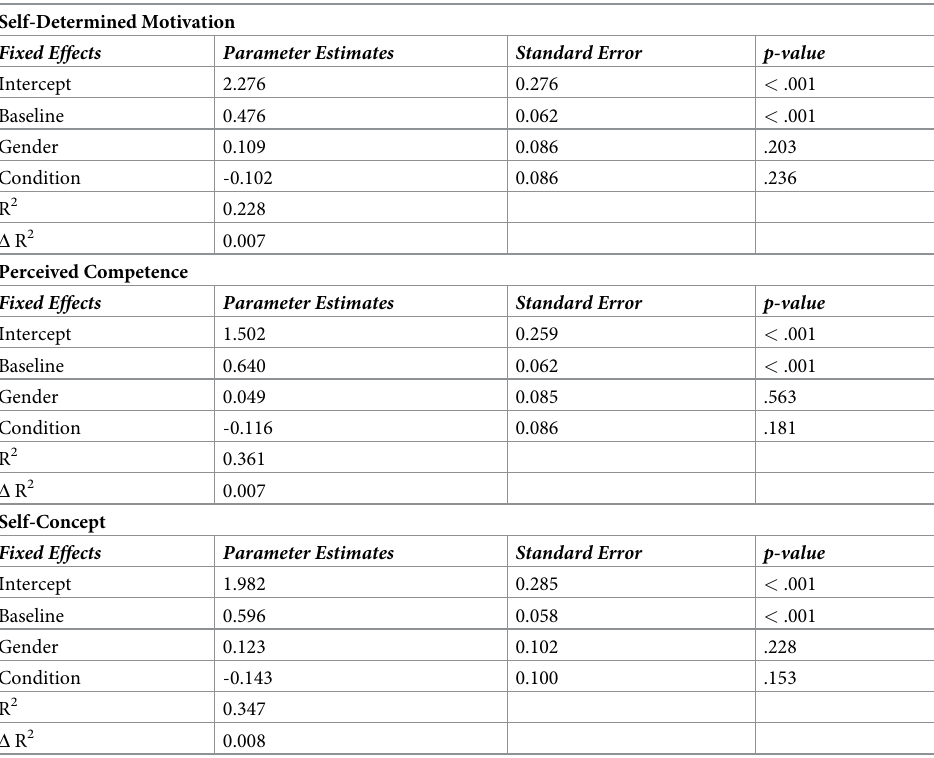
Table 4. Grade 3/4 psychological